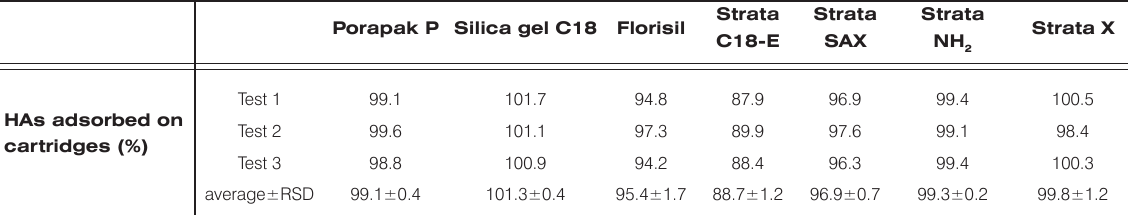
Table 2. The adsorption performances of the tested sorbents (200 mL ultrapure water spiked with 1 mg